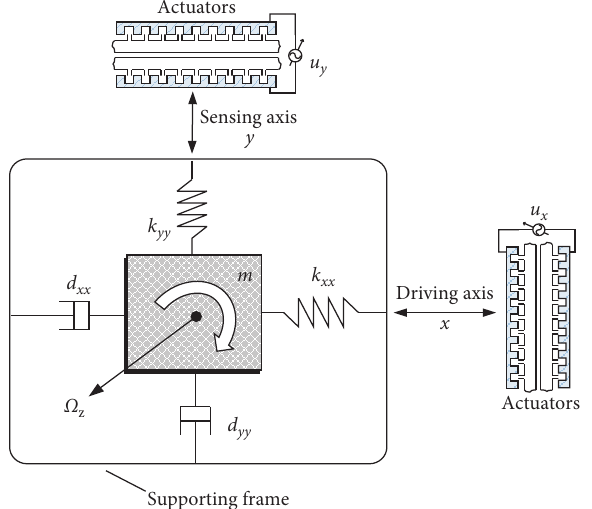
Figure 1: Schematic structure of a z -axis